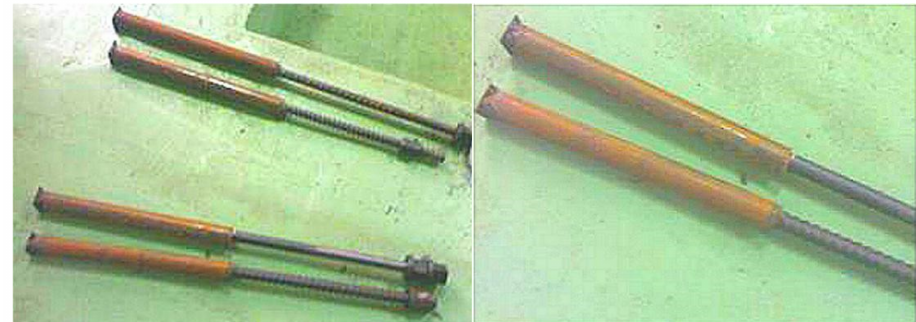
Figure 11. Anchorage tests of the left-hand and right-hand threaded steel